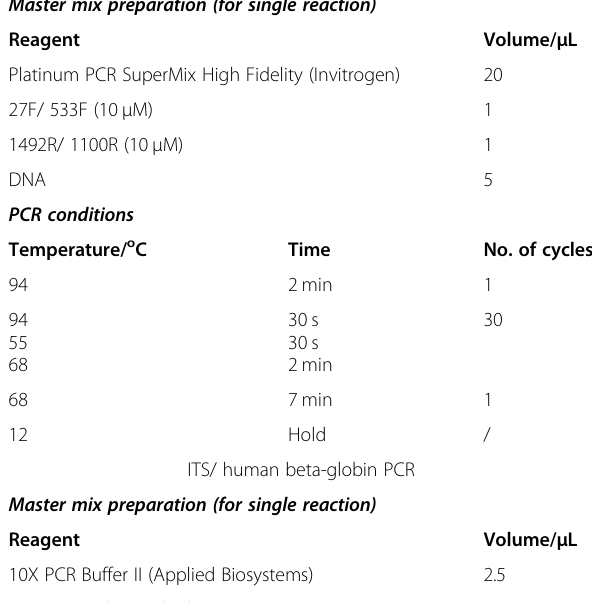
Table 3 Master mix constituents and PCR conditions 16S PCR